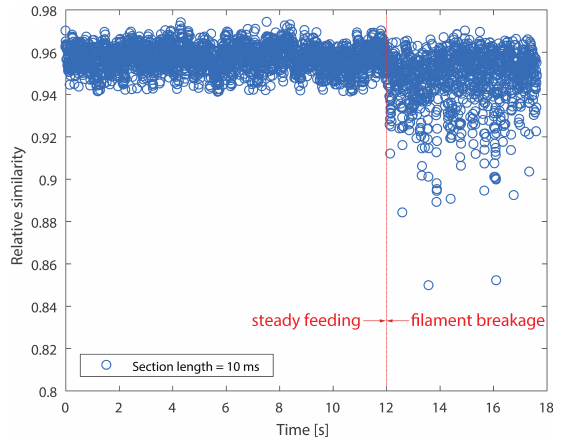
Figure 11. Relative similarity of AE signal for Test #2 (section length = 10